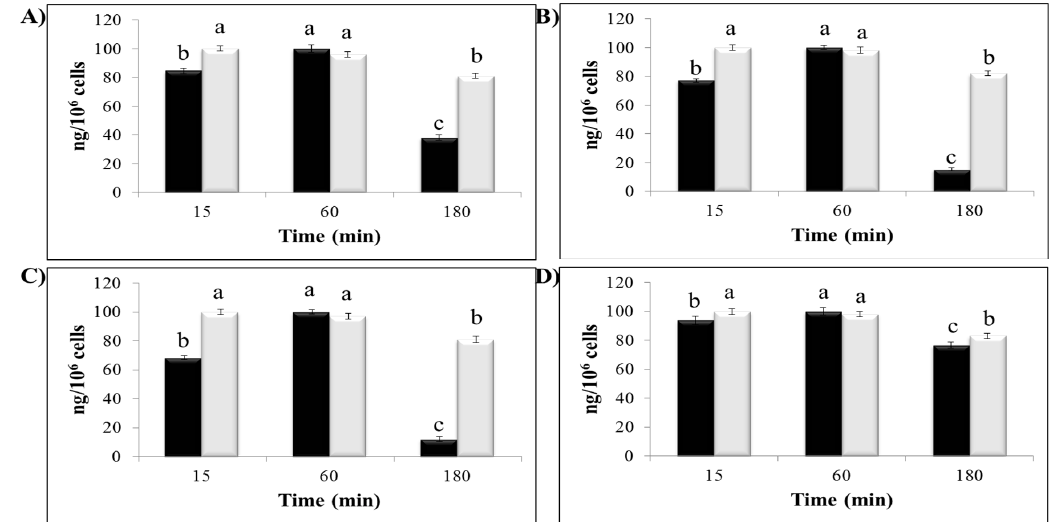
Figure 4. Cellular content of chestnut shell extract (CSE) (10 µg/mL) and GA (10 µg/mL) in blood non-adherent leukocytes and intestinal intraepithelial non-adherent leukocytes after 15, 60, and 180 min of incubation (black columns) and CSE and GA concentration in the medium after different incubation times (white columns). ( A ) and ( B ) CSE and GA content in intestinal intraepithelial non-adherent leukocytes, respectively; ( C ) and ( D ) CSE and GA content in blood non-adherent leukocytes, respectively. CSE concentration is expressed as ng/10 6 cells. The data represent mean ± SD. Different letters on the columns indicate statistically significant differences.